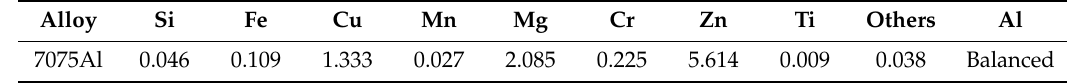
Table 1. Chemical compositions (weight percent) of 7075Al.